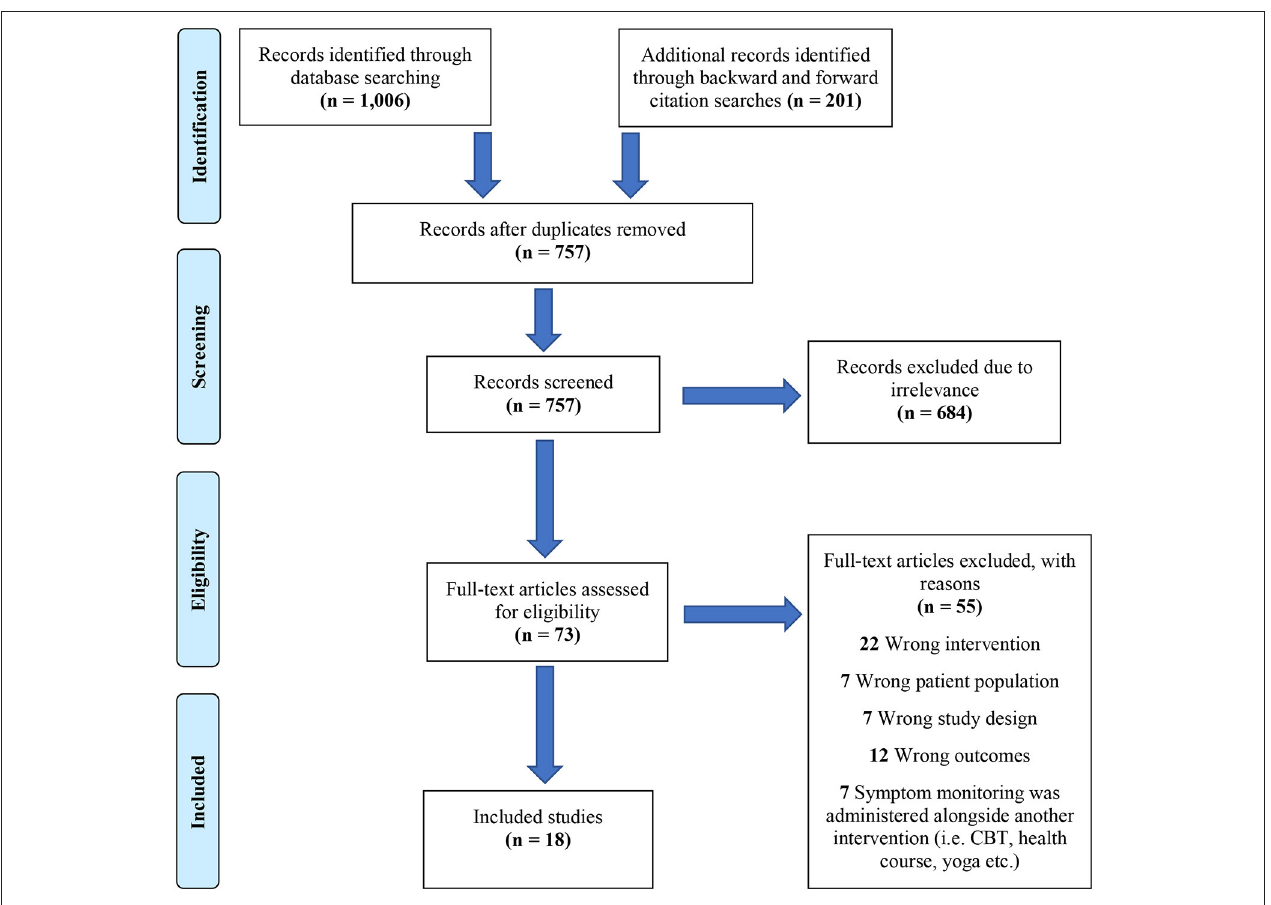
FIGURE 1 | PRISMA flowchart of study selection